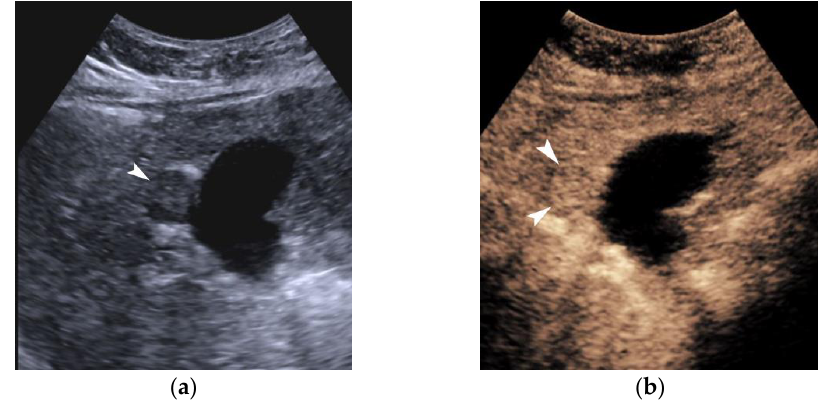
( g ) Figure 2. CEUS findings of a large HCC. B-mode ( a ) showing an ill-defined mildly hypo-echoic mass (outlined by arrowheads) inside the right lobe of a cirrhotic liver complicated with ascites.